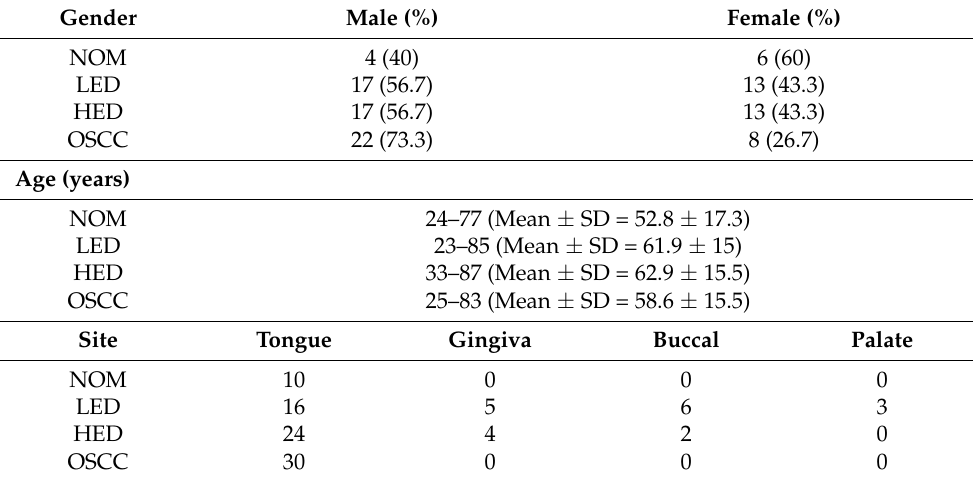
Table 1. Clinical characteristics of NOM, LED, HED, and OSCC